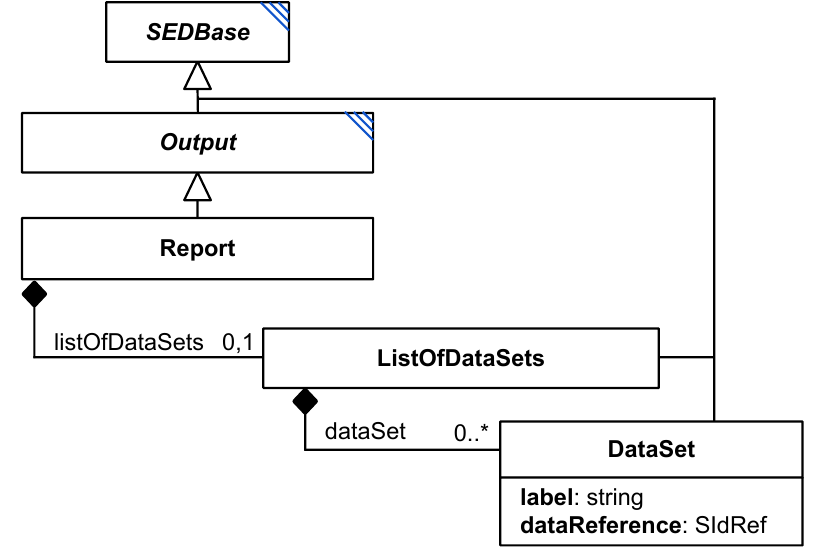
Figure 2.24: The definition of the SED-ML Report, ListOfDataSets, and DataSet